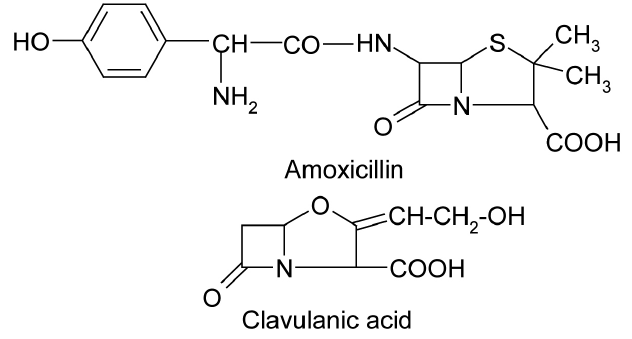
FIGURE 1 - Chemical structures of AMX and